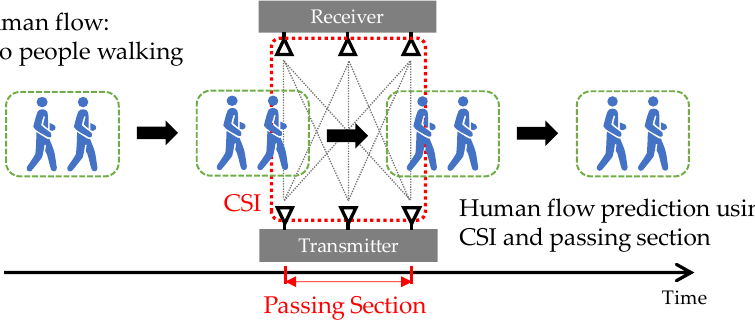
Figure 1. Overview of human flow prediction.